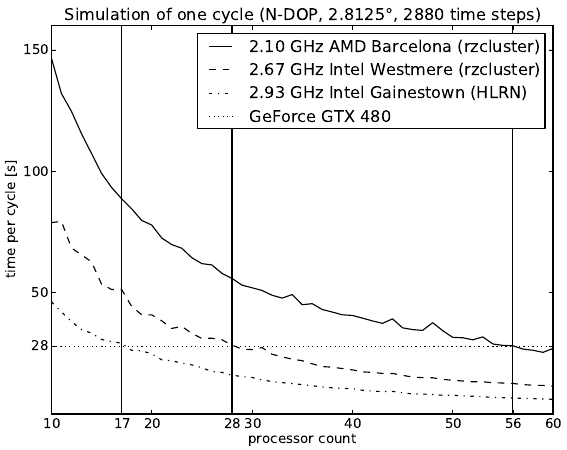
Fig. 5. Comparison between CPU cluster and the used GPU for one model year for the N-DOP model, (“rzcluster” refers to the Kiel University cluster, “HLRN” to the cluster of the North-German Su- percomputing Alliance ).